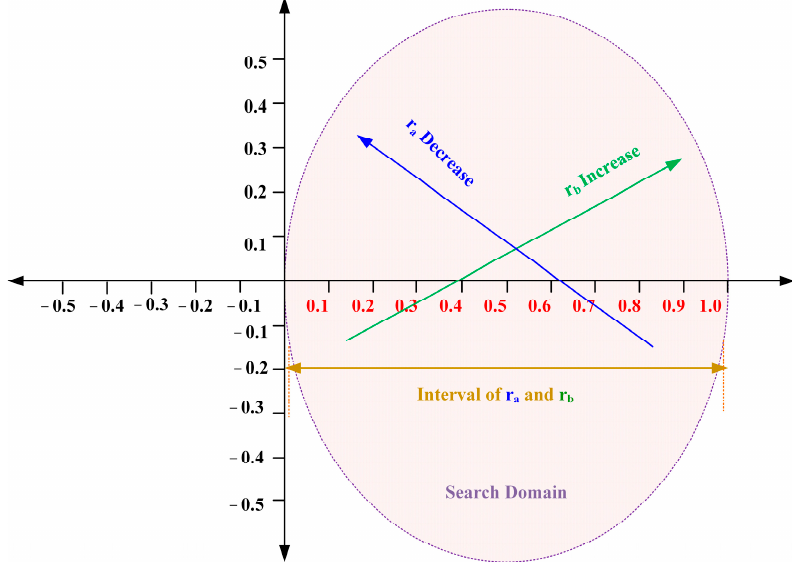
Figure 1. Visualization of adaptive parameters in GSR.